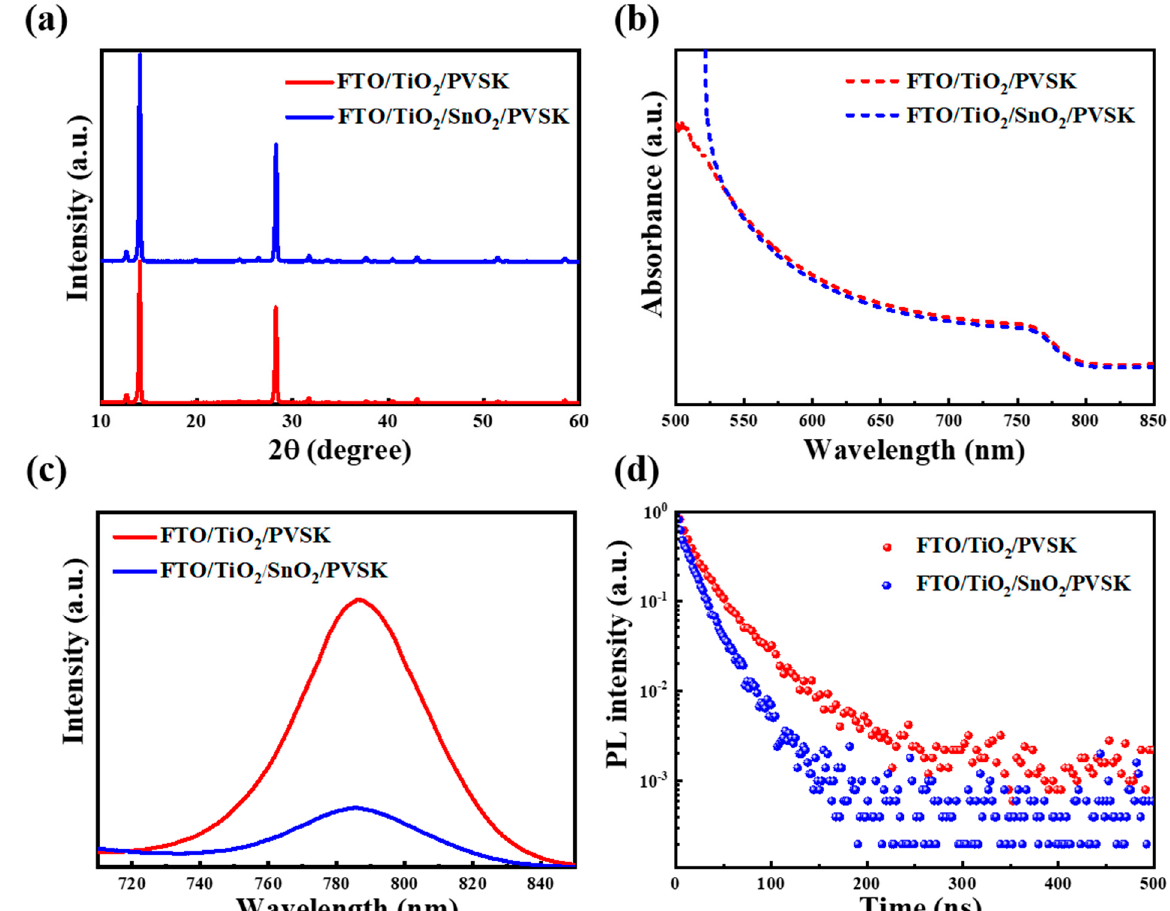
Figure 3. ( a ) XRD patterns, ( b ) absorption spectra, ( c ) PL spectra and ( d ) TRPL curves of the perovskite films deposited on FTO/TiO 2 and FTO/TiO 2 /SnO 2 substrates. In addition, the steady-state photoluminescence (PL) and time-resolved photolumi-